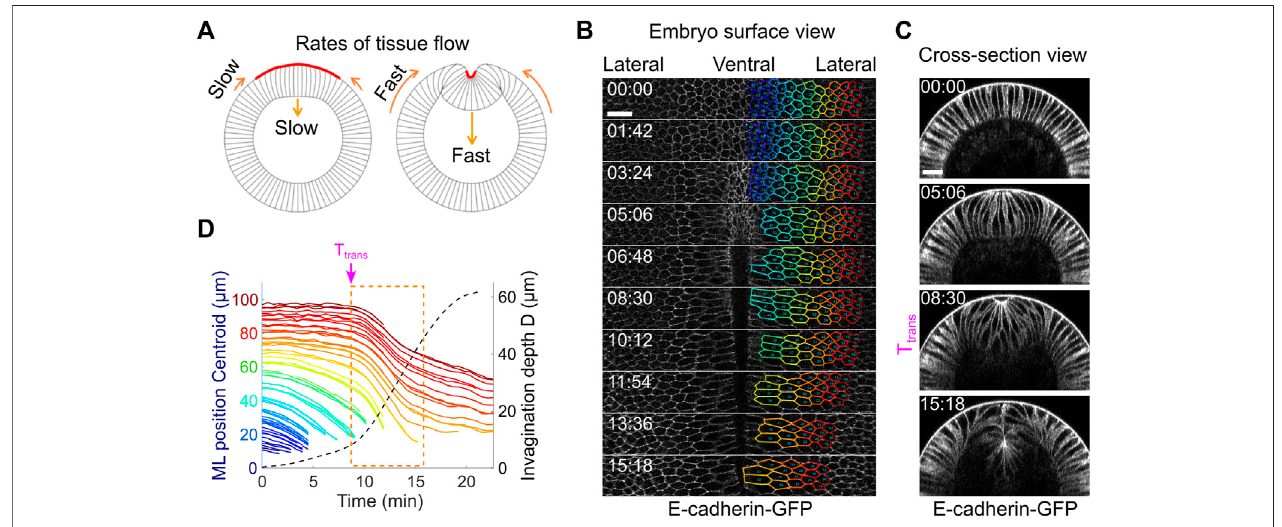
FIGURE6| Tissuedynamicsduringventral furrowformation. (A) Cartoonshowingthepredicted accelerationoftissue deformation(orange arrows)afterT trans that resemblesthe “ snap-through ” duringanelasticbucklingprocess. (B) Surfaceviewofanembryoshowingtrackedcelloutlinesduringventralfurrowformation. (C) Cross- section view of the same embryo shown in (B) . (D) The relation between cell movement towards ventral midline (solid lines) and the invagination depth D (dotted line) in realembryos.Eachsolidlinerepresentsasinglecell,andthecolorofthelinescorrespondstothecolorofthecelloutlinesin (B) .Therapidaccelerationinmesoderm invagination and ectoderm movement happens immediately after T trans (dashed orange box). Shown is a representative measurement out of N = 3 embryos. All scale bars: 20 μ m.